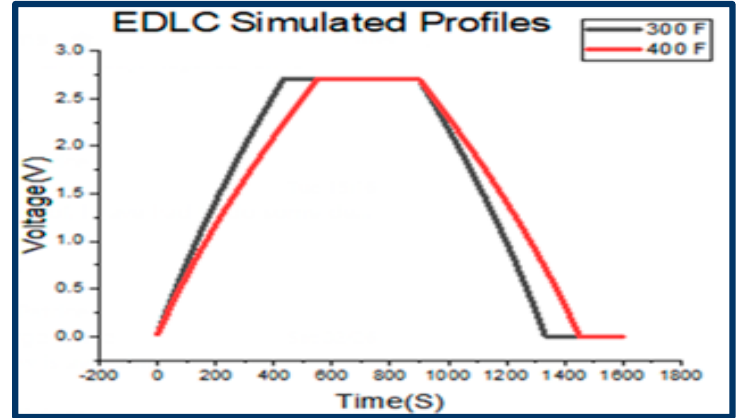
Figure 8. Simulated-PMS-charge/discharge profiles for the EDLCs.